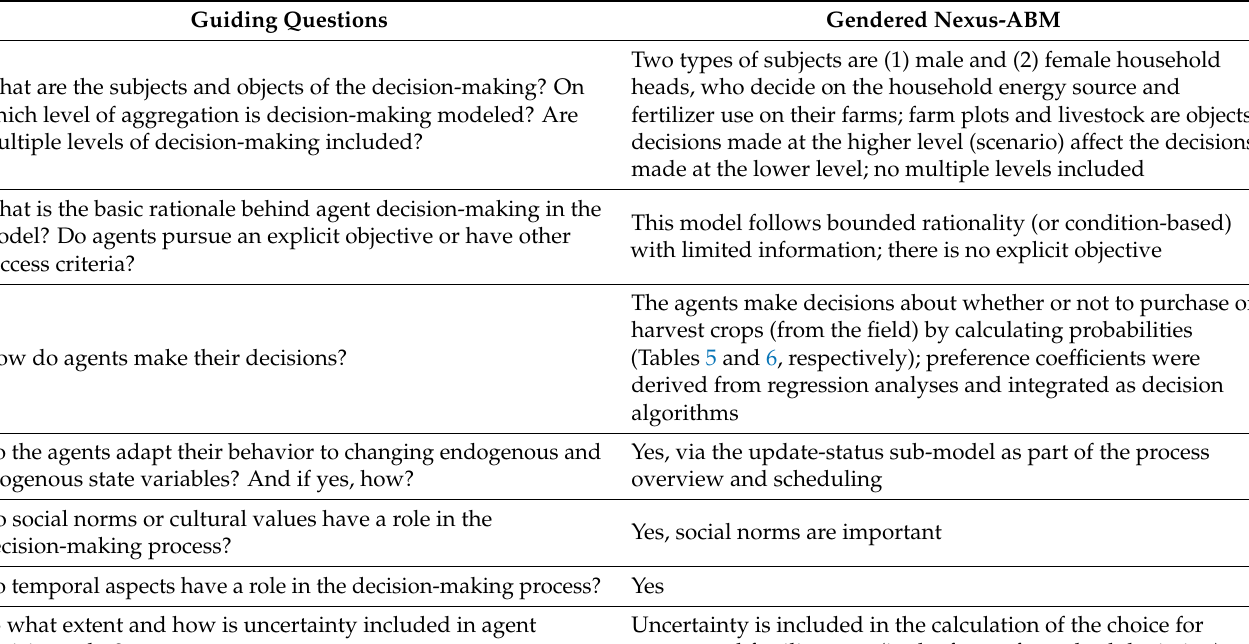
Table 4. Decisions protocol description of the gendered nexus-ABM